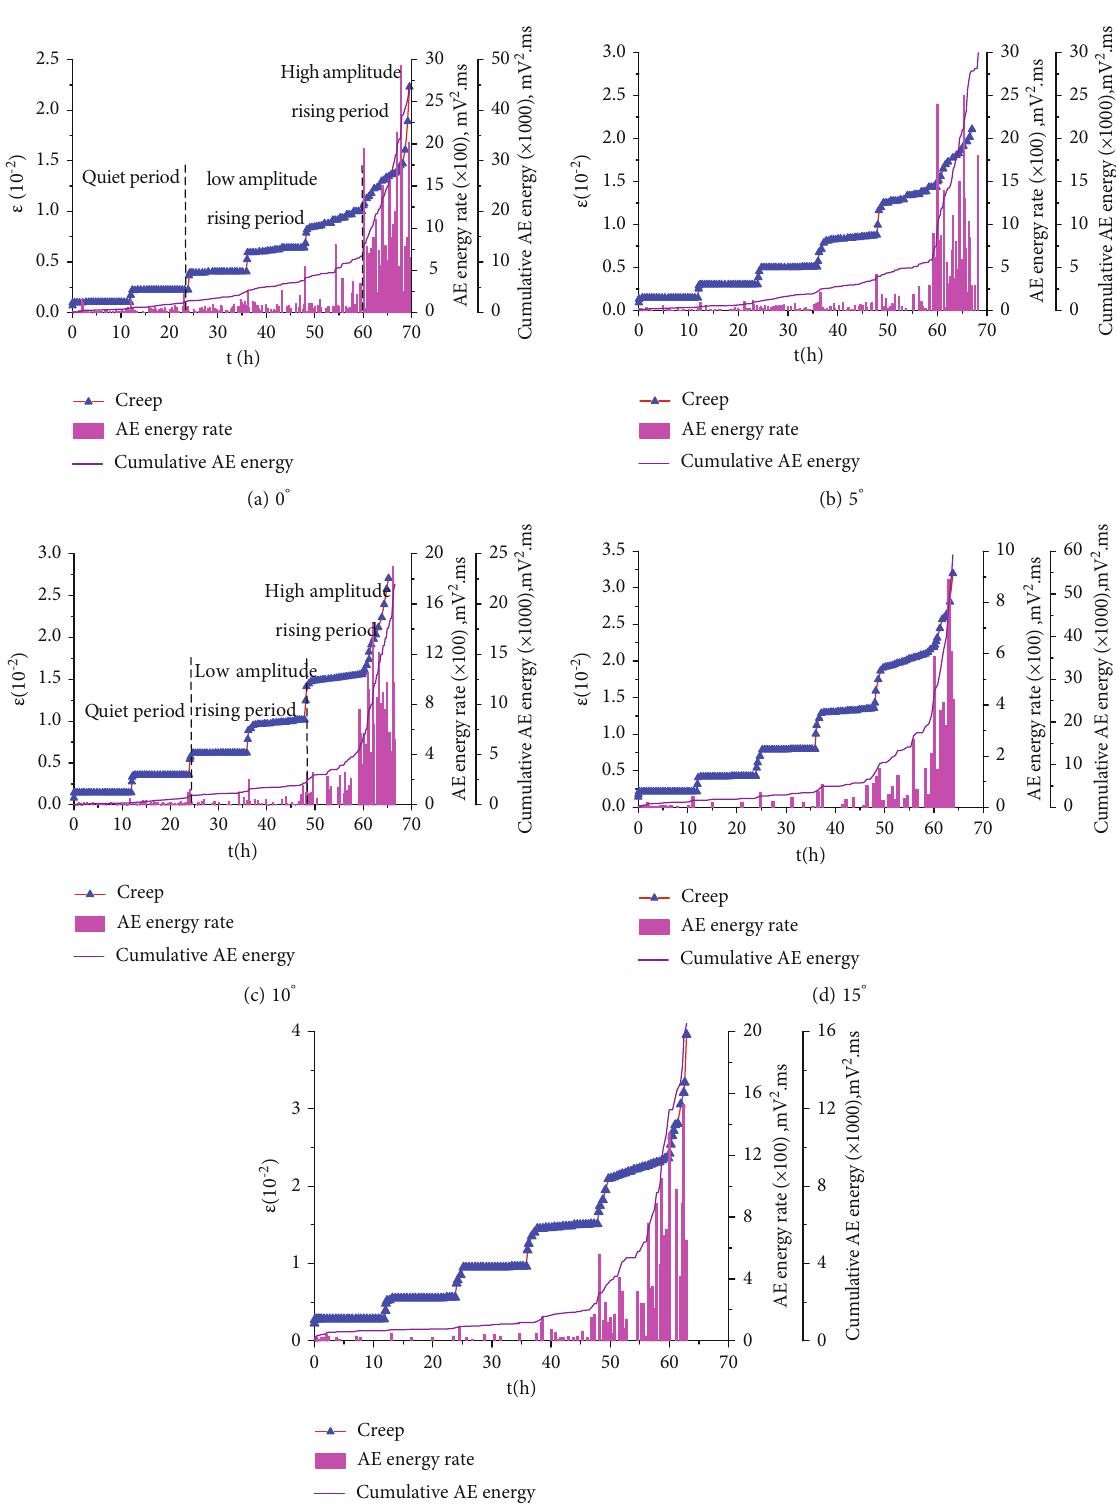
Figure 12: Relationship between AE energy and creep strain of coal specimens under various inclination